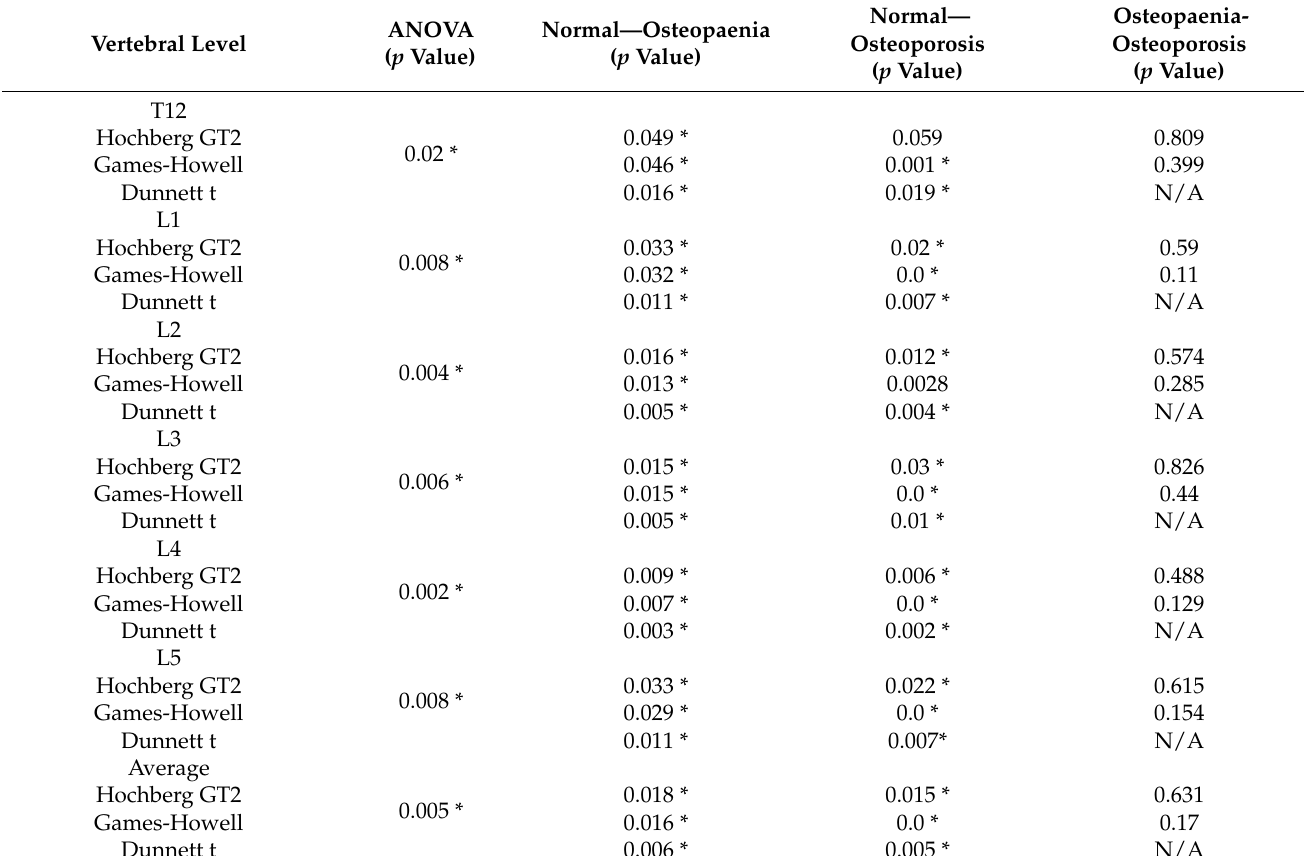
Table A2. One-way ANOVA to assess the significance of the variance in mean CT-HU for each of the DXA derived diagnostic categories, at each vertebral